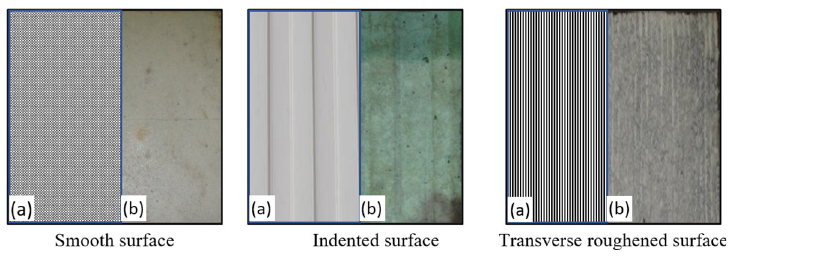
Fig 4. Surface textures of the top surface of the concrete base: a) schematics and b) actual surfaces.